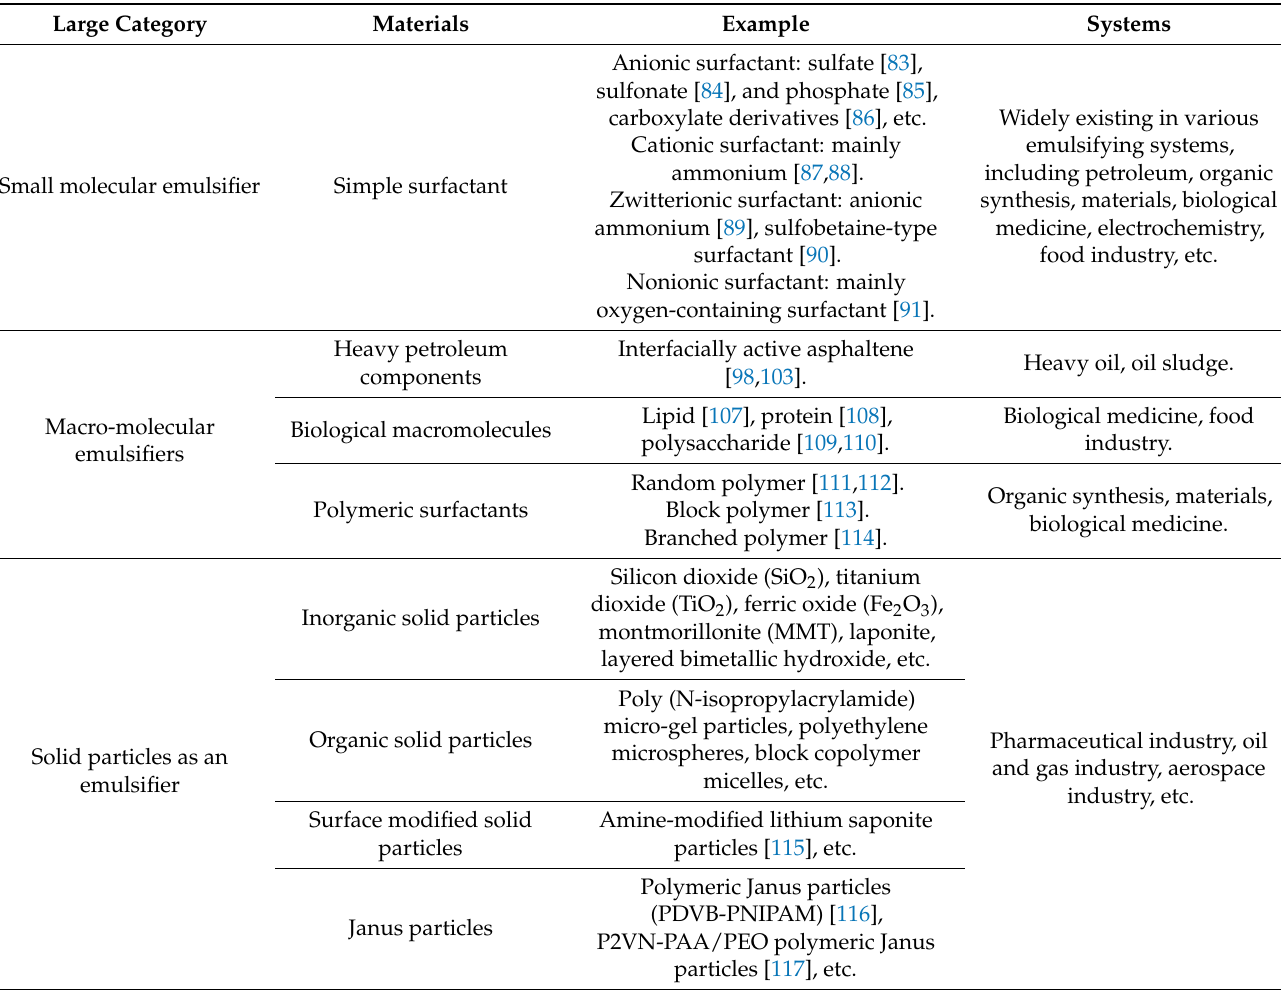
Table 8. The typical examples of each kind of